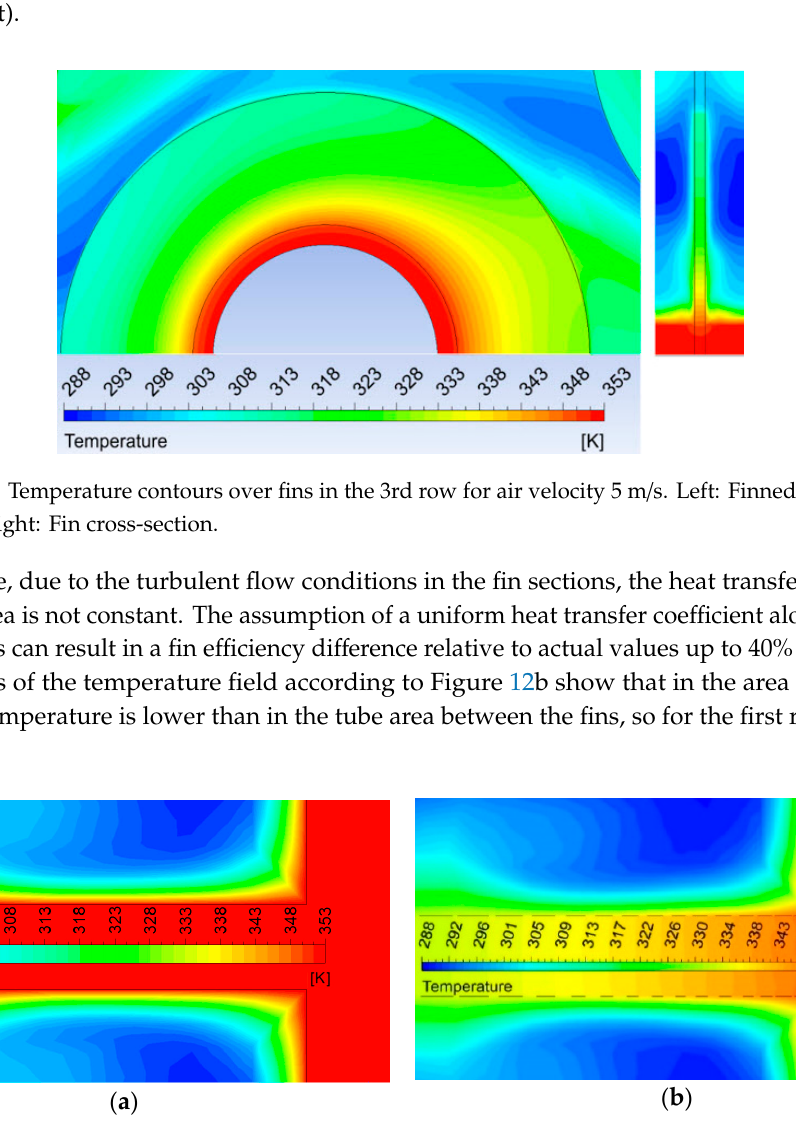
Figure 12. Fin temperature contours: ( a ) Temperature contour at λ = 16,000 W/(mK). ( b ) Temperature contour at λ = 16 W/(mK).